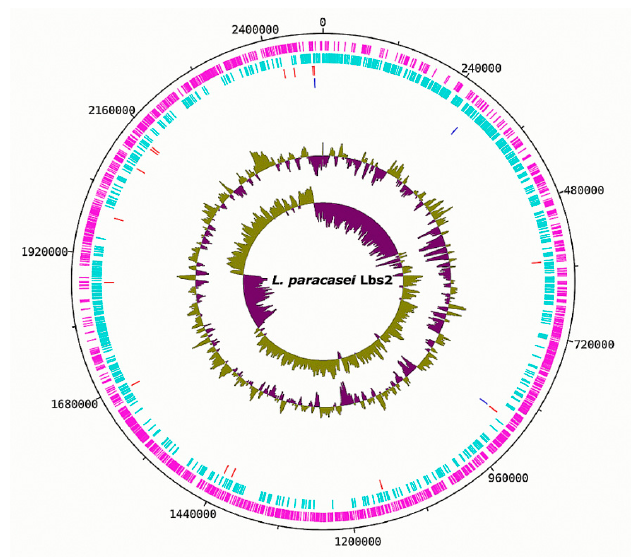
Figure 1. Circular map of the L. paracasei Lbs2 genome. Labeling from outside to inside of the circle, each ring carries information of the genome: coding sequences (CDSs) on the forward strand (magenta); CDSs on the reverse strand (cyan); tRNA genes (red); rRNA genes (blue); GC content; GC skew.